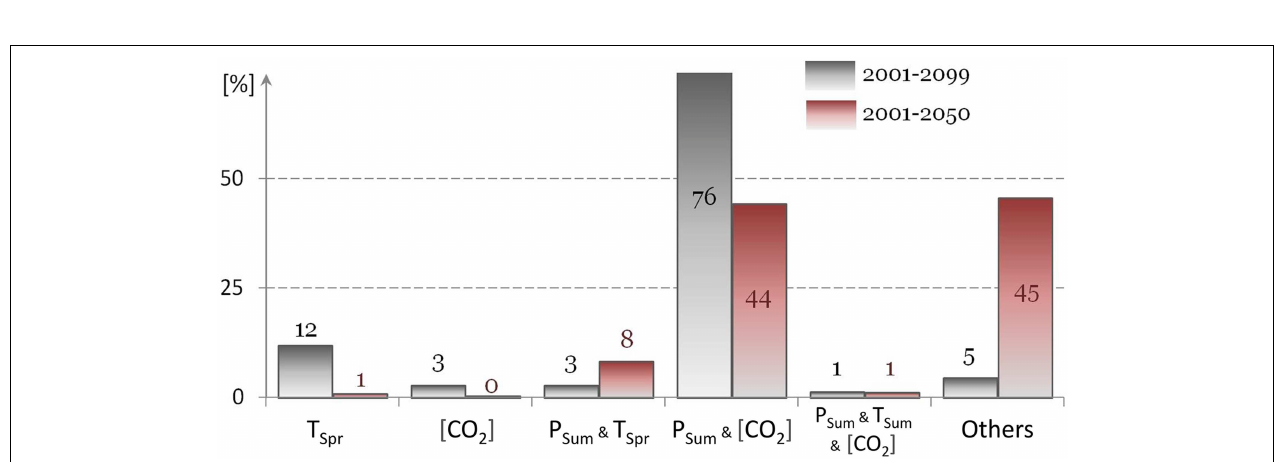
FIGURE 8 | Percentage of optimal MLR models by model composition and time periods. The presented list of model combinations is not